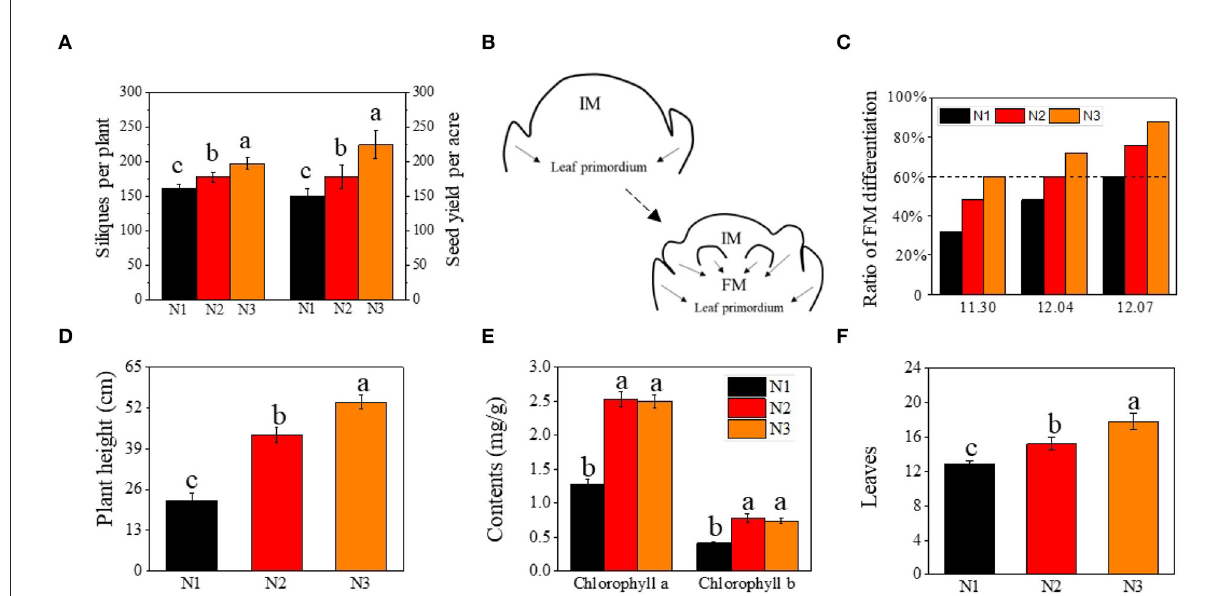
FIGURE1 Effects of low N (N1), normal N (N2), and high N (N3) rates on silique number, and yield of rapeseed, floral meristems differentiation, plant height, chlorophyll contents, and leaves. (A) silique number and seed yield per acre; (B) the morphogenesis of floral meristems initiation; (C) ratio of floral meristems differentiation (%) under different N rates at different sampling stage; (D–F) represent plant height (cm), chlorophyll contents (mgg − 1 ), and leaves, respectively; FM represented floral meristem. IM represented inflorescence meristem. Error bars represented SD value. Different lower cases represented significance at p ≤